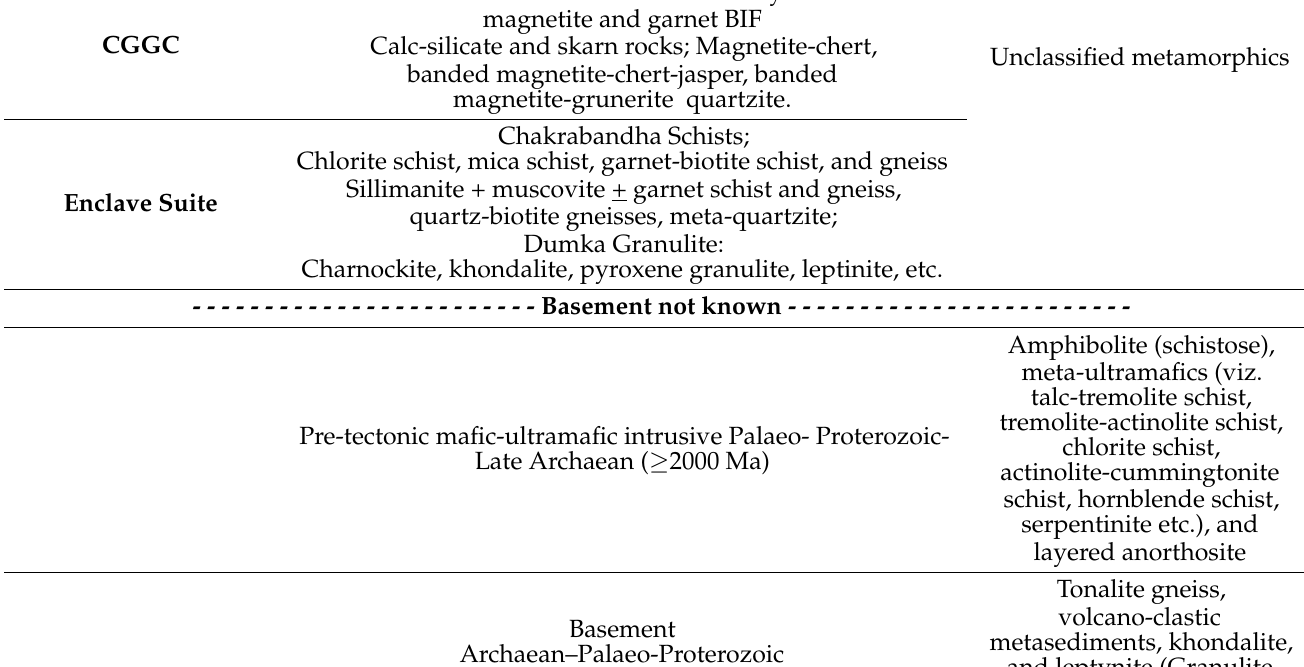
Compiled Geological Map of GSI (1:2 Million